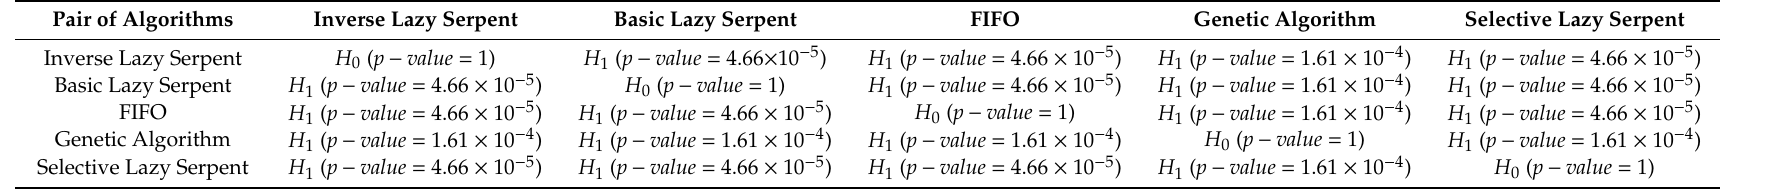
Table 5. Statistical comparison between the optimization algorithms based on the Mann–Whitney U